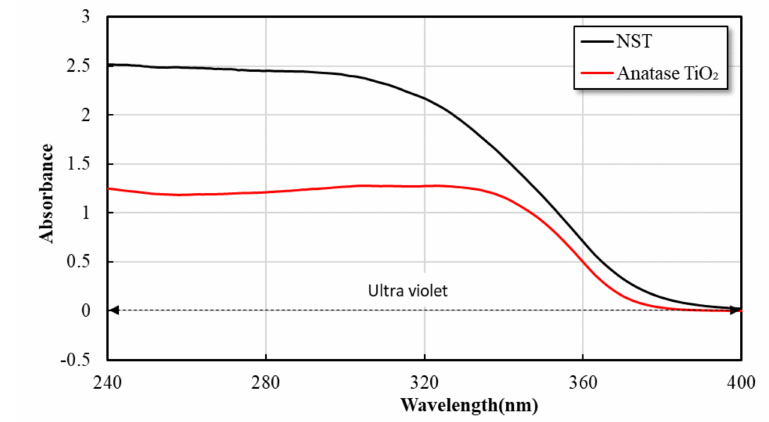
Figure 4. UV-Vis absorbance of